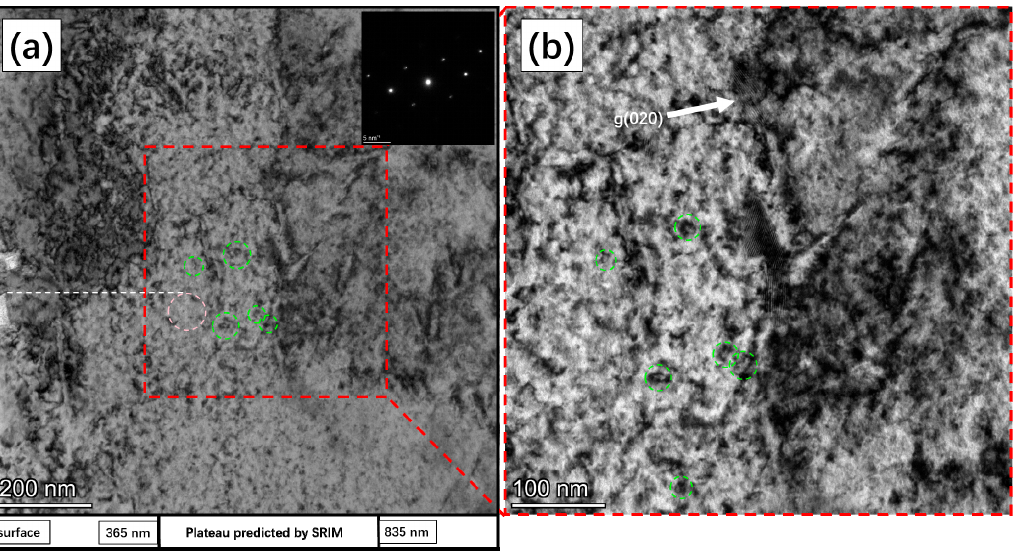
Figure 5. TEM bright field (BF) ( a ) and magnified image ( b ) of A508-3 steel at plateau damage level of 1.5 dpa predicted by SRIM. The BF images were taken under two-beam BF conditions using a diffraction vector of g = (020) near the [001] zone axis. The pink circle indicates that the dislocation loops are visible at g = (110), and the green circle indicates that the dislocation loops are visible at g = (020). The white dashed line is used to highlight the same position under different g vector. In order to study the type of dislocation loops under diffraction vectors g = (110) and g = (020) in more detail, we examined the differences between the same positions in Figure 6a,b, as marked by the pink and green circles. Many dislocation loops became invisible when the diffraction vector changed from g = (110) to g = (020). There were many disloca- tion loops with a Burgers vector of b = [100] in the irradiated steel. Meanwhile, few dis- location loops became visible that indicated the existence of dislocation loops with Burg- ers vectors of b[11(cid:3364)1] or b[11(cid:3364)1(cid:3364)] . Figure 6. The same position in the A508-3 steel under two diffraction vectors, g = (020) ( a ) and g = (110) ( b ), near the [001] zone axis. The pink circle indicates that the dislocation loops are visible at g = (110), and the green circle indicates that the dislocation loops are visible at g = (020).